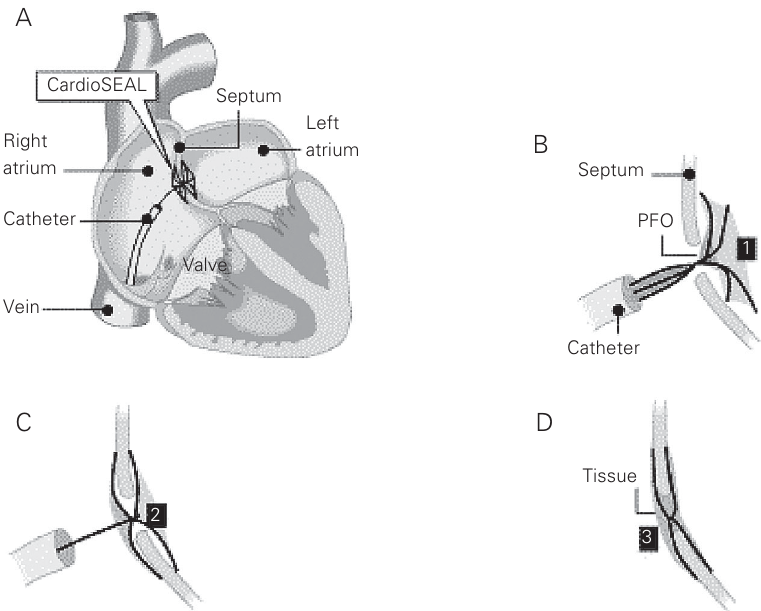
Figure 6. Atrial septal occlusion device. A , Scheme of the heart with the device in place. B , The first half of the device is placed in the left atrium. C , The second half of the device is placed in the right atrium. D , The catheter is withdrawn and the tissue begins its recovery. PFO = patent foramen ovale. Taken from Ref. 26 (http://www.nmtmedical.com).